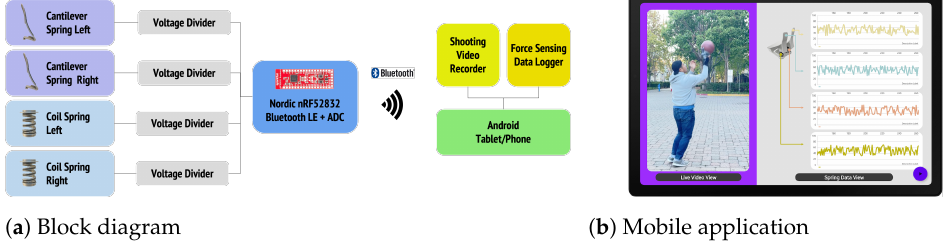
Figure 13. Block diagram ( a ) and mobile application ( b ) of Shooter’s Touch. This system allows the shooters to record changes in force in real time while recording their actual